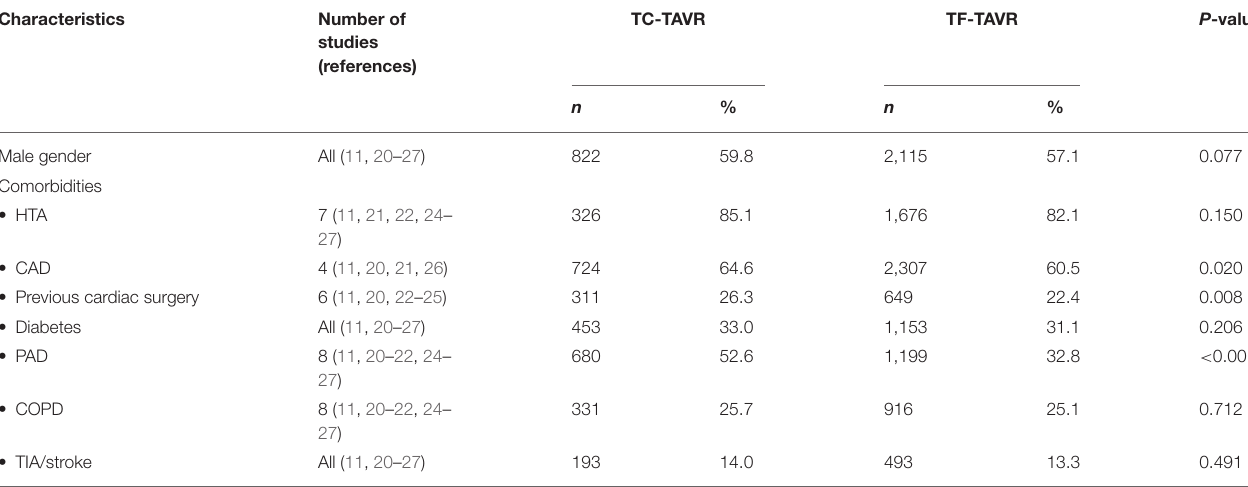
TABLE 2 | Comparison of dichotomous patient characteristics between TF-TAVR and TC-TAVR cohorts. Characteristics